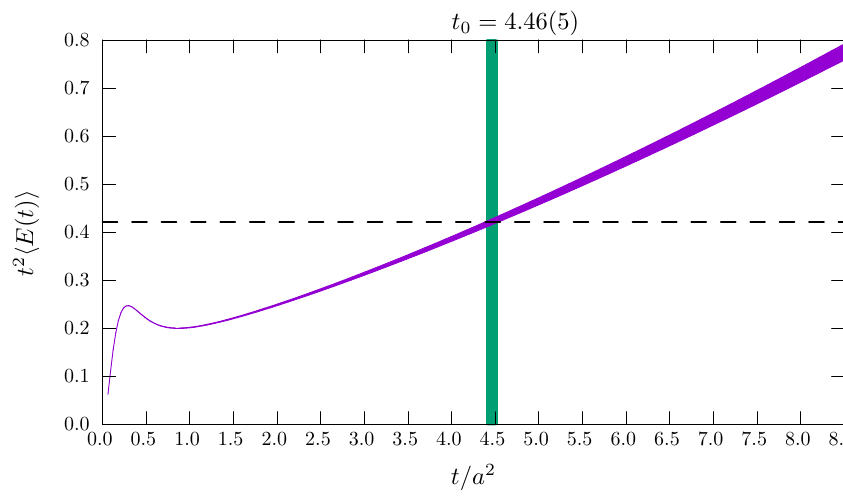
Fig. 8 The purple band shows t 2 (cid:4) E ( t ) (cid:5) with its uncertainty, while the vertical green band is the value of t 0 implicitly defined (cid:4) E ( t ) (cid:5) = by requiring t 2 0 0 0 . 421875. As expected after